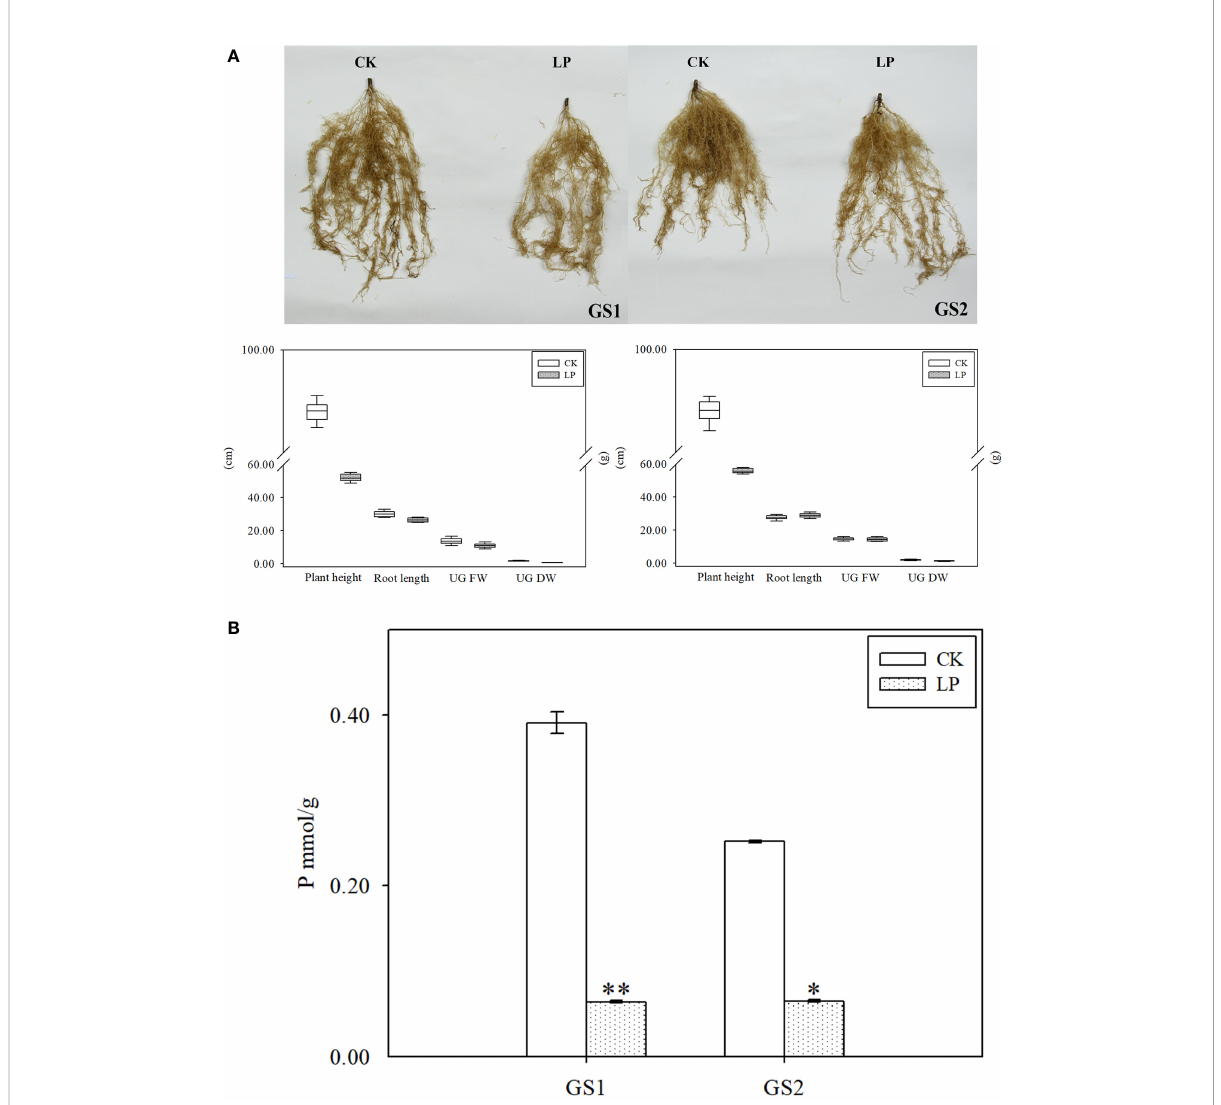
FIGURE 1 (A) Root phenotypes and (B) phosphorus content of roots of two ecotypes of wild soybean seedlings under control and low-phosphorus stress. GS1, common wild soybean; GS2, barren-tolerant wild soybean; CK, control group; LP, low-phosphorus stress group. * Signi fi cant at P<0.05, ** signi fi cant at